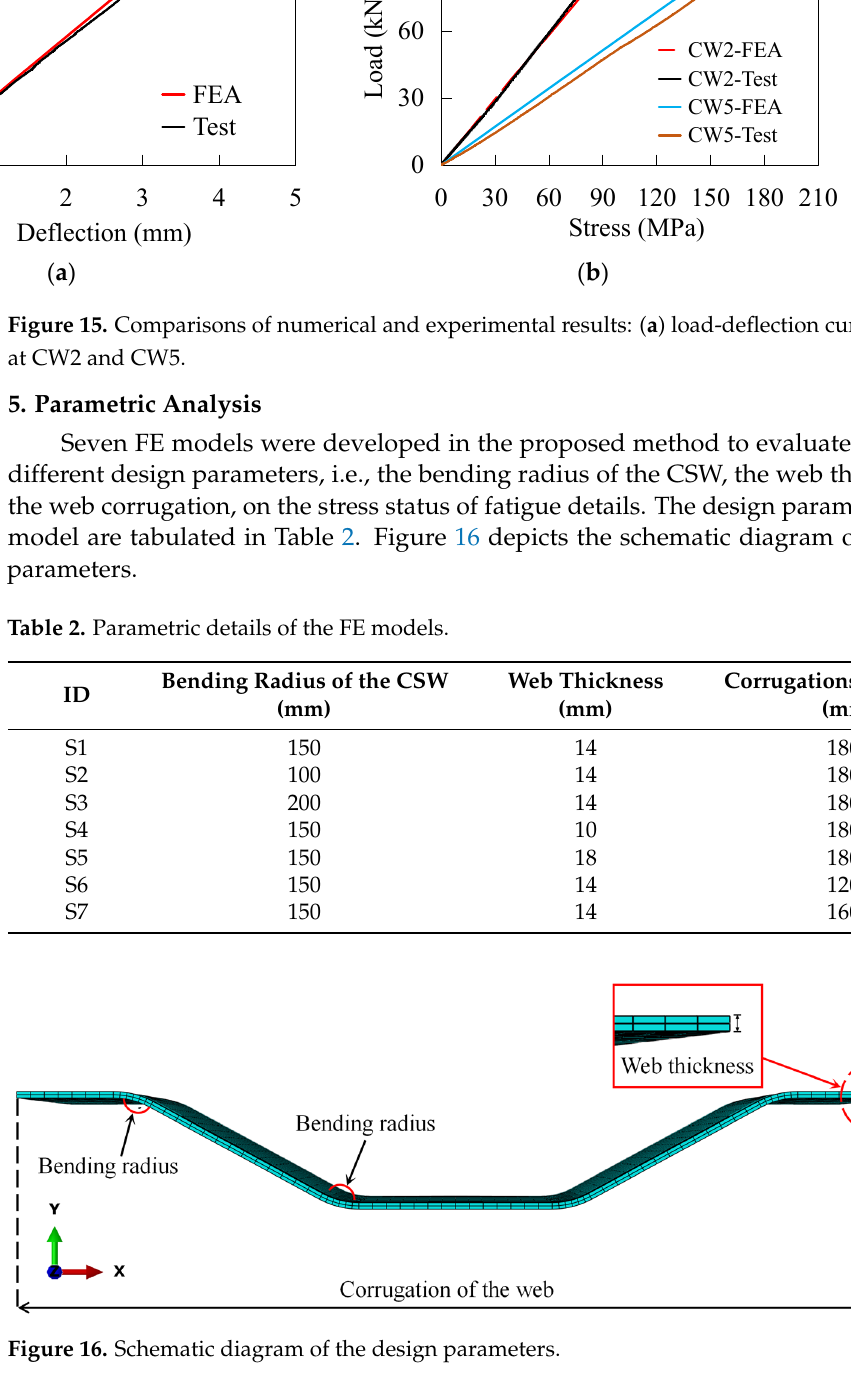
Figure 16. Schematic diagram of the design parameters.